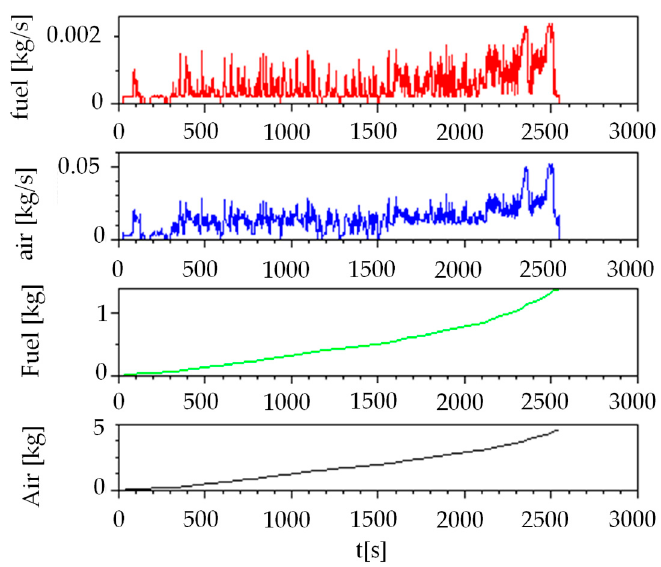
Figure 6. Parameters obtained from the “ Calculations for fuel/air” simulation block.